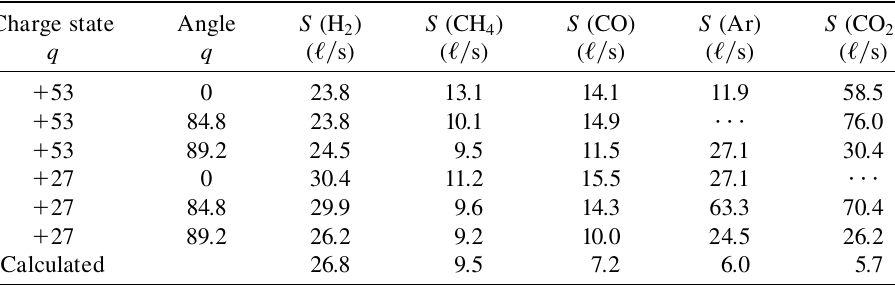
TABLE II. Estimated pumping speeds S , tabulated as a function of the ion charge state q and the impact angle (cid:6) , extracted from fits to measurements on chamber A. Normal incidence corresponds to (cid:6) (cid:6) 0 (cid:7) . Note that the noise on the argon partial pressure measurement is large compared to the pressure change due to pumping. The pumping speed estimates for argon are therefore very